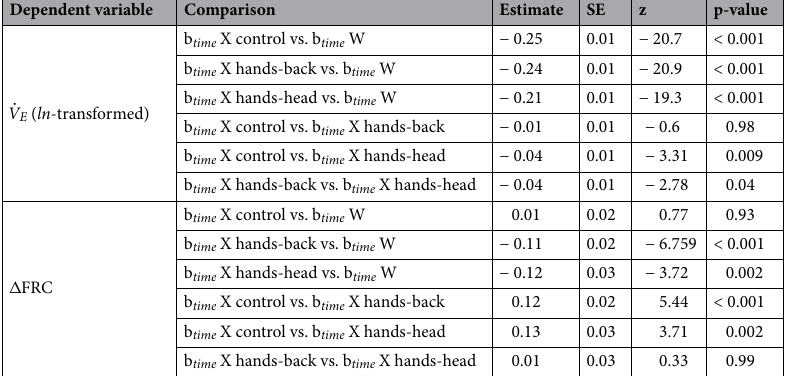
hyperinflation of the lungs to counteract the external load. The divergence of (cid:31) FRC values from W 1 to W 5 seen in Fig. 4 demonstrated that (cid:31) FRC responses to the external load were initially consistent, but responses to the weight over time were heterogeneous, with subject age and BMI accounted for by the mixed-effects regression model used. This heterogeneity of response, specifically subjects with (cid:31) FRC declines in phase W, may be an important factor for predicting the rate of phase X (cid:31) FRC decreases during weighted restraint and exhaustion- ˙ V recovery. The E decreases observed in phase W were consistent with MVV decreases previously observed between unweighted and weighted prone positions 5 . ˙ V The slope of E for each posture group, shown in Table 6 and Fig. 3, was a steeper negative slope than in ˙ V phase W, as expected during exercise recovery. The shallower E recovery slope for the hands-head restraint posture compared to the hands-back and control postures, with equal relative resistive loads, exercise intensity, and controlling for BMI and age, suggested that this slower recovery rate could be an effect of the hands-head